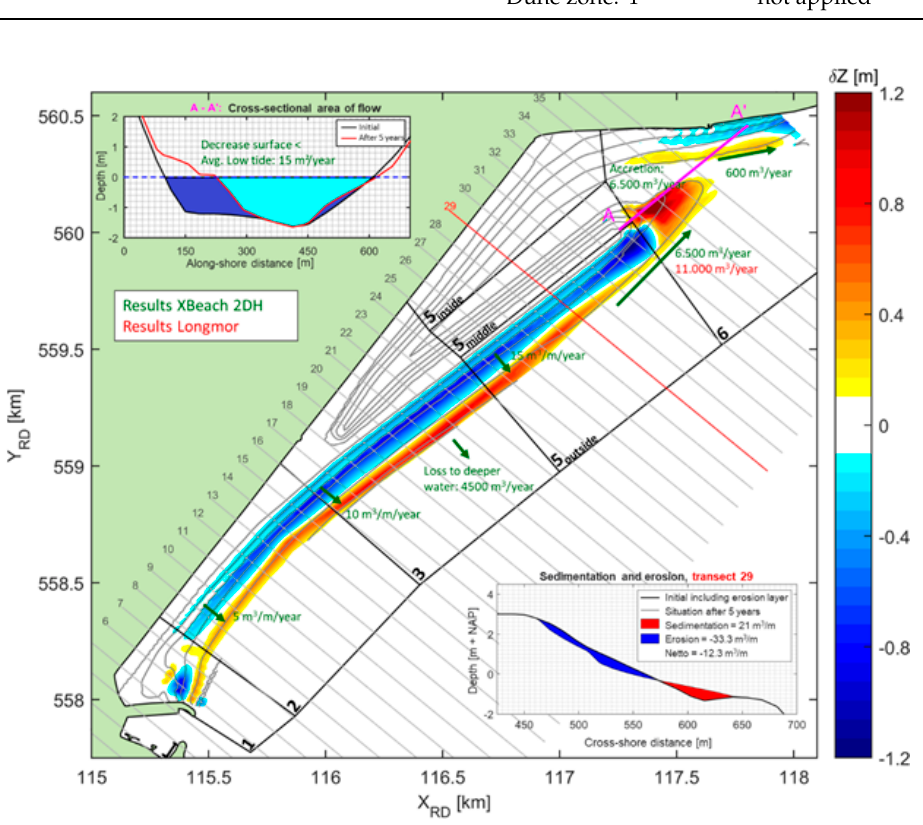
Figure 9. Computed erosion and deposition patterns over five years based on the Xbeach2dh-model; d 50 = 0.4 mm. d 50 = 0.4